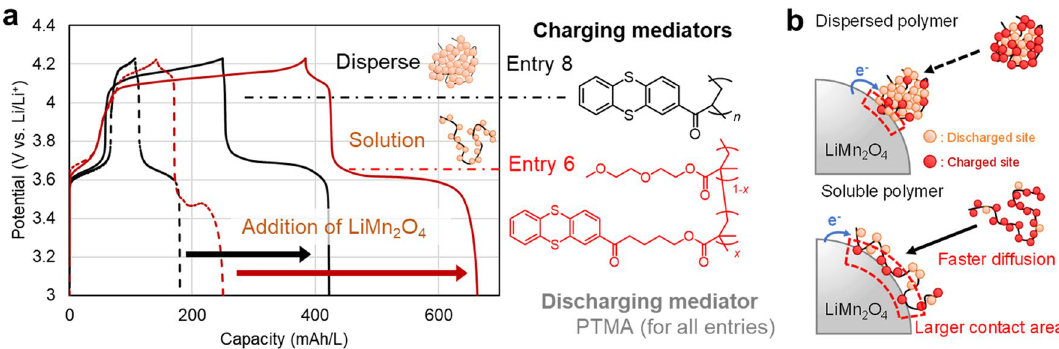
Figure 4. ( a ) Charge/discharge curves for the LiMn 2 O 4 and polymer mediator cells, operated at 0.25 C for mediators (Entries 5–8). Dashed (Entries 5, 7) and solid (Entries 6, 8) lines represent the results without and with the existence of LiMn 2 O 4 . ( b ) Comparison of dispersed and soluble redox mediators to oxidize the inorganic